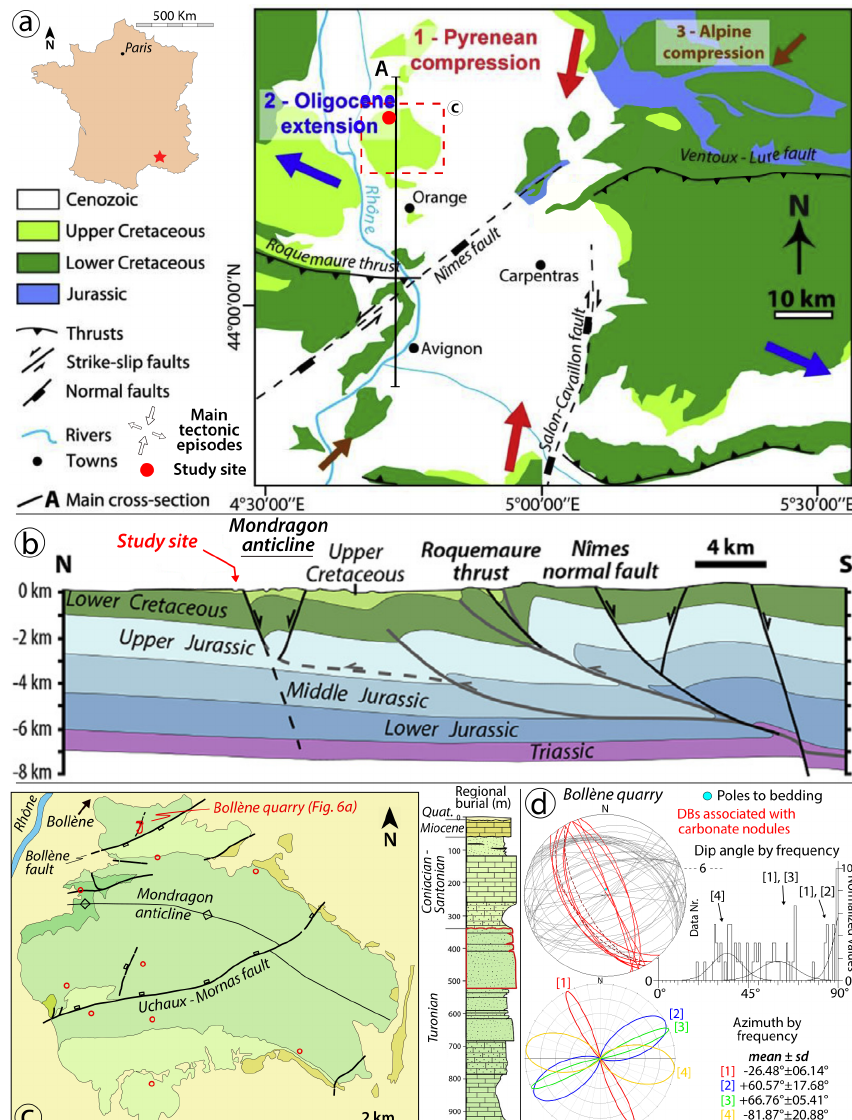
Figure 2. (a) Schematic geologic map and (b) cross section of the Southeast Basin, Provence, France. The main tectonic episodes affecting the region are reported in (a) . (c) Geologic map and stratigraphic column of the Bollène quarry. The location of the map in (c) is indicated by a red square in (a) , and red open circles indicate some past study locations (see Wibberley et al., 2007; Saillet and Wibberley, 2010; Ballas et al., 2012, 2013, 2014; Soliva et al., 2013; Philit et al., 2018). Panels (a) and (b) as well as the stratigraphic column in (c) are modified from Philit et al. (2015, 2018). The geological map in (c) is modified from Ballas et al. (2012). (d) Lower-hemisphere equal-area projection indicates the orientation of the different sets of DBs (64 data points) at the study site. DBs associated with carbonate nodules are highlighted in red. Dotted lines indicate the main attitude of tabular carbonate nodules. DBs azimuth (strike; N ± 90 ◦ ) frequency rose diagram and dip angle ( ◦ ) plotted against frequency. Best-fit Gaussian curves superimposed on the corresponding data histograms (frequency distributions). Gaussian peaks and related standard deviations ( ± SD) are indicated for each population. The numbers in square brackets [ n ] are the same as used in Fig. 6b to rank different sets of